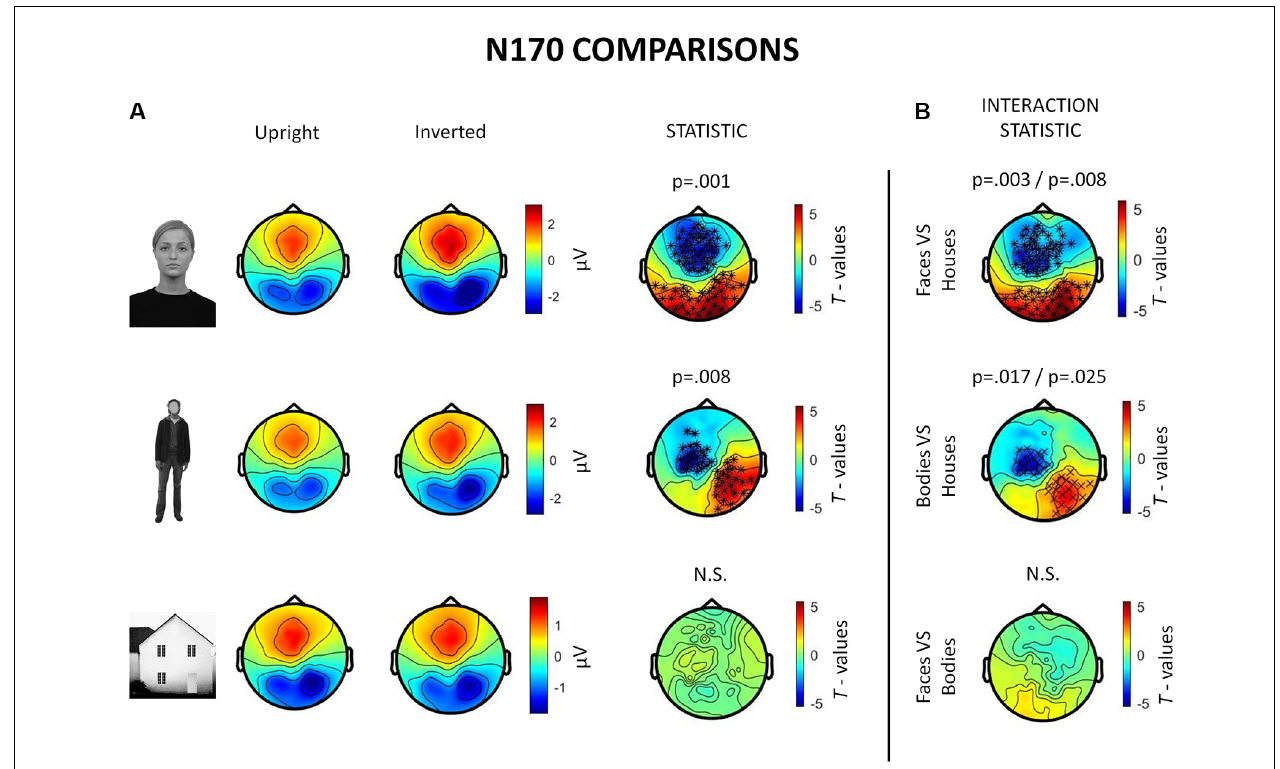
FIGURE 4 | Summary of ERP results. All topographies were obtained by calculating the average voltage over the time-window of interest (TOI) for N170 components (i.e., 140–200 ms after stimulus onset). (A) Topographies show the activity evoked by upright and inverted faces (first row), bodies (second row) and houses (third row). The third column of topographies shows clusters where statistically significant differences between upright and inverted stimuli were found by means of non-parametric cluster-based permutation tests. Inverted faces and bodies showed a larger N170 (occipito-temporal areas) and VPP (vertex positive potential, frontal areas) than upright stimuli. (B) Topographies show the results of comparisons between inversion effects (i.e., interaction effects): the first and the second images show that face inversion and body inversion lead to significantly different changes in activity over the previously reported areas when compared to house inversion. The third image shows that face and body inversion effects did not differ in a statistically significant